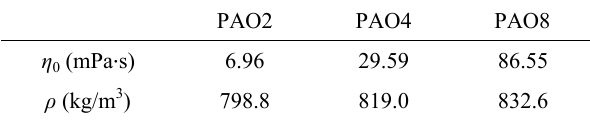
Table 2 Lubricant properties ( t 0 = 25 ° C).